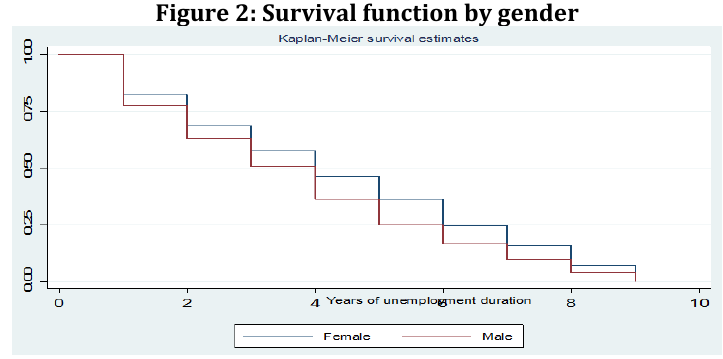
Figure 2: Survival function by gender